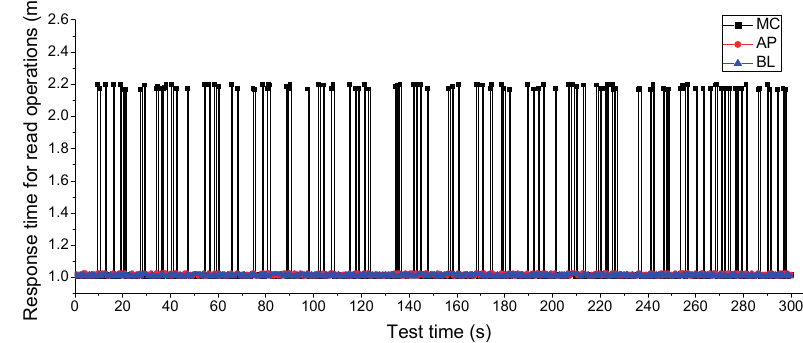
Figure 12. Response time for the read operation of Baseline (BL), Meta-Cure (MC), and Asymmetric Programming